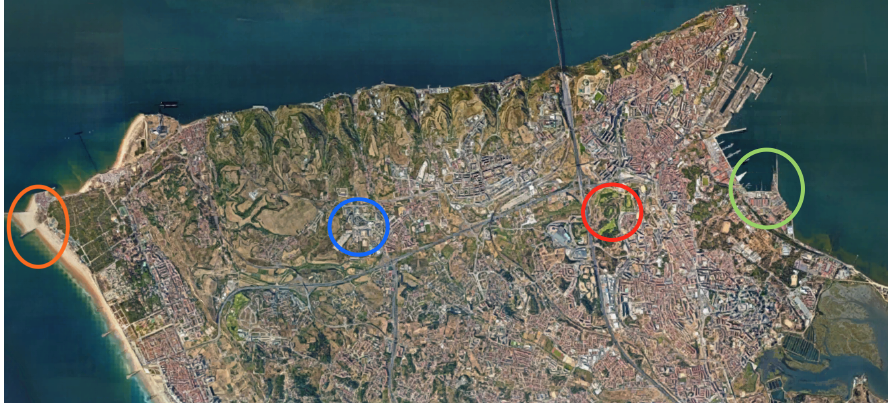
Figure 4. Data collection localization in Portugal. The circles show the areas where the data set was